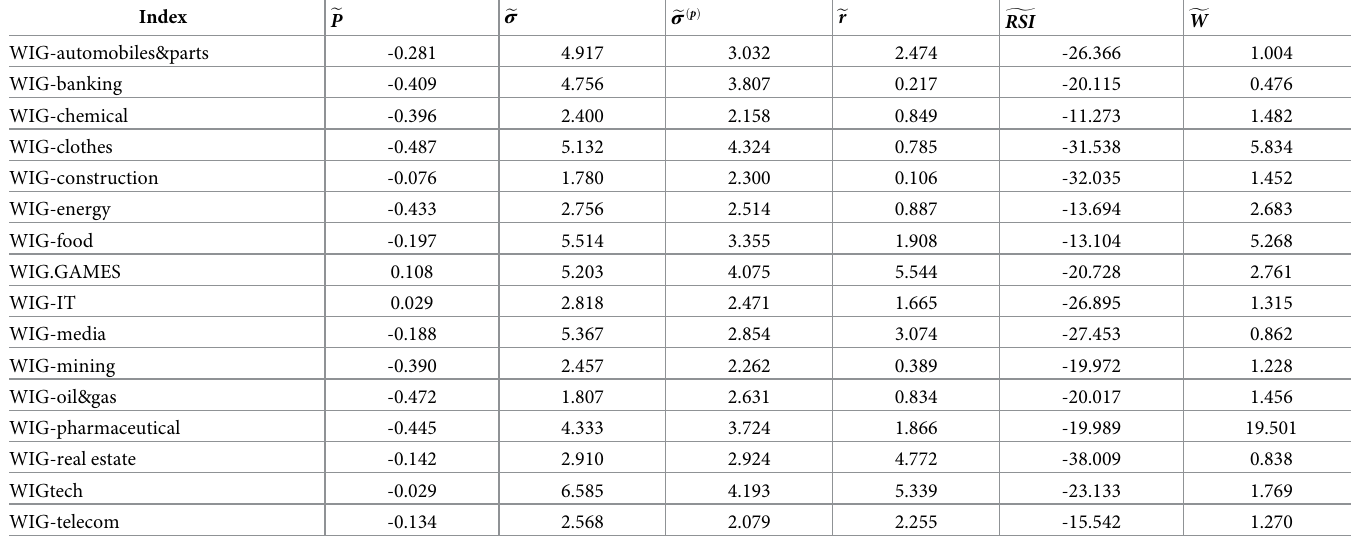
Table 3. Values of the proposed measures for evaluated